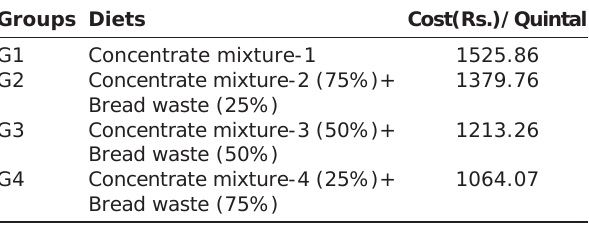
Table-2: Grouping of animals, their diet and cost of diet. Groups Diets Cost(Rs.)/Quintal